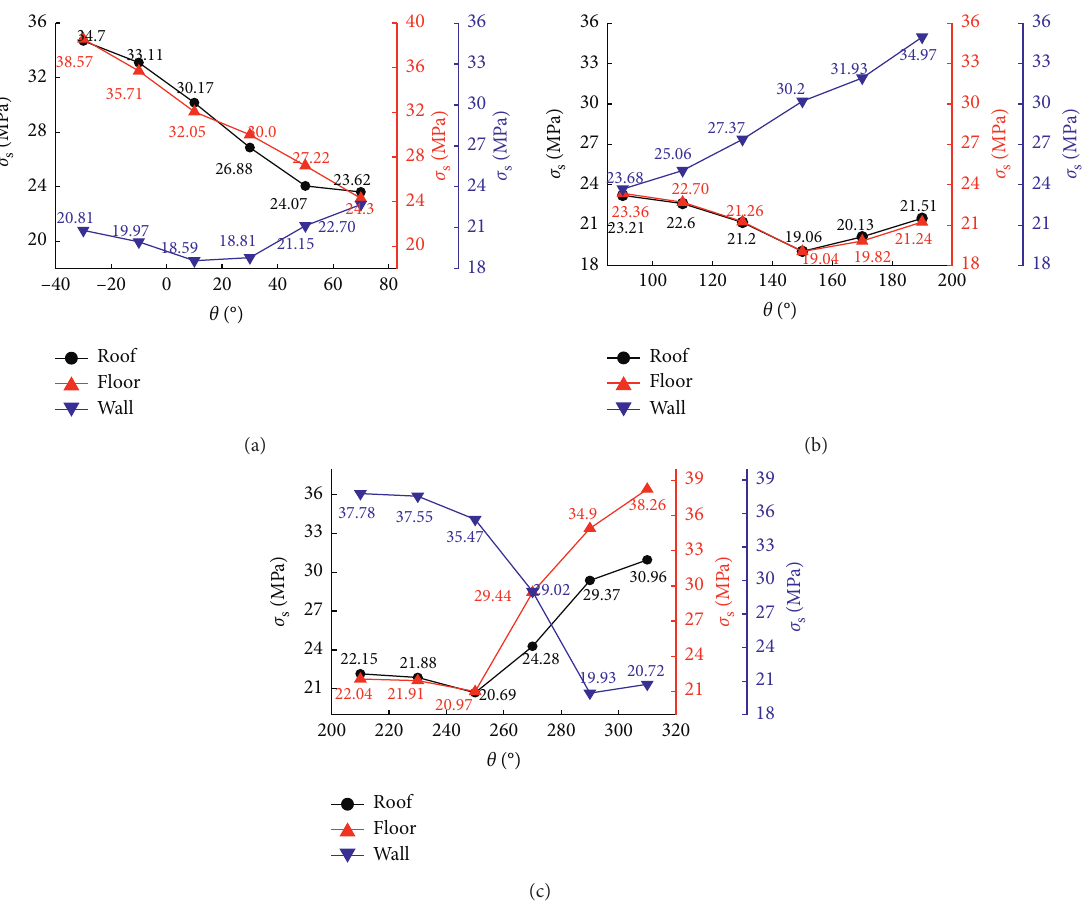
Figure 5: Evolution of the principal stress difference maxima. (a) σ